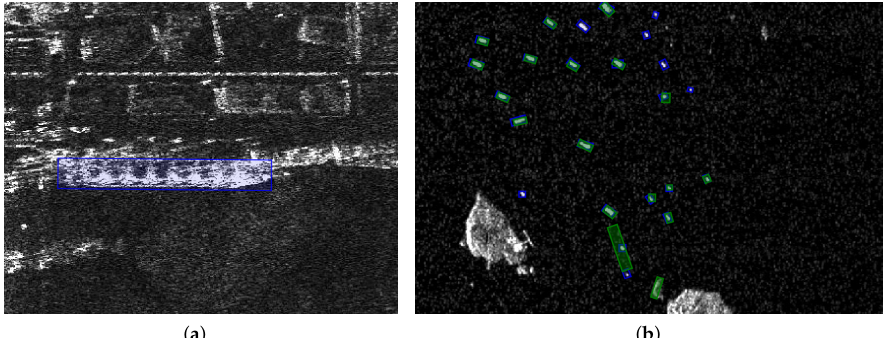
Figure 13. Visualization of the false cases of the proposed method on two SSDD test images. The blue and green rectangles are the ground truth boxes and the detected boxes, respectively. ( a ) a ship by the harbour is failed to be detected. ( b ) some small ships are failed to be detected and key points from different ships are mistakenly